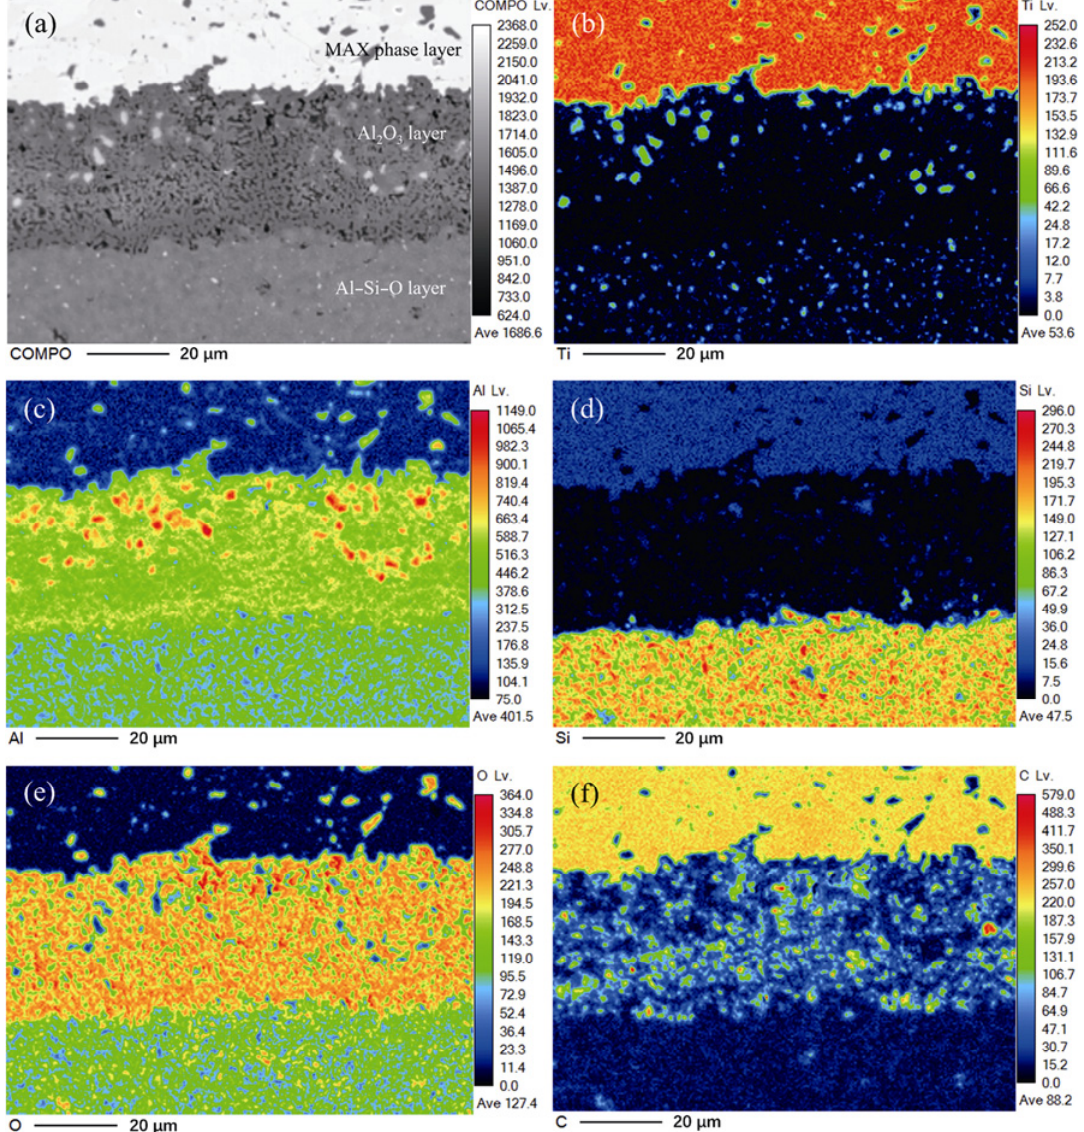
Fig. 5 (a) Micrograph of a three-layered structure converted from the Ti 3 AlC 2 /SiO interface in the sandwich sample; elemental distributions of (b) Ti, (c) Al, (d) Si, (e) O, and (f)